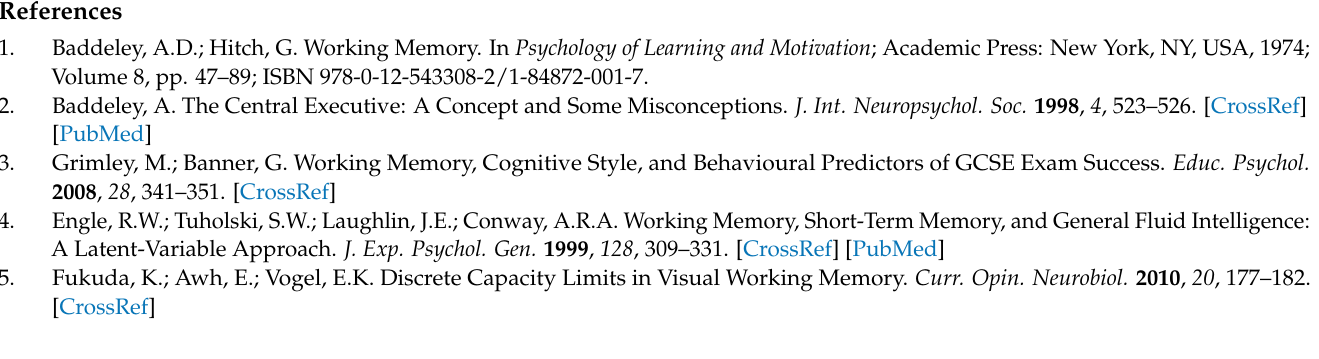
Table S4: A summary of the replication sample results from pairwise comparisons of the mean PLV across the high and low frequency bands. A false discovery rate correction was to correct for multiple comparisons. The FDR column denotes which comparisons were significant after correction. When marking significance, * significance after FDR